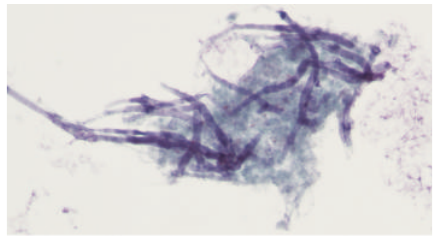
Figure 3: The histological appearance of Aspergillus hyphae with septae, branching at 45 ∘ (silver methenamine, × 1000).